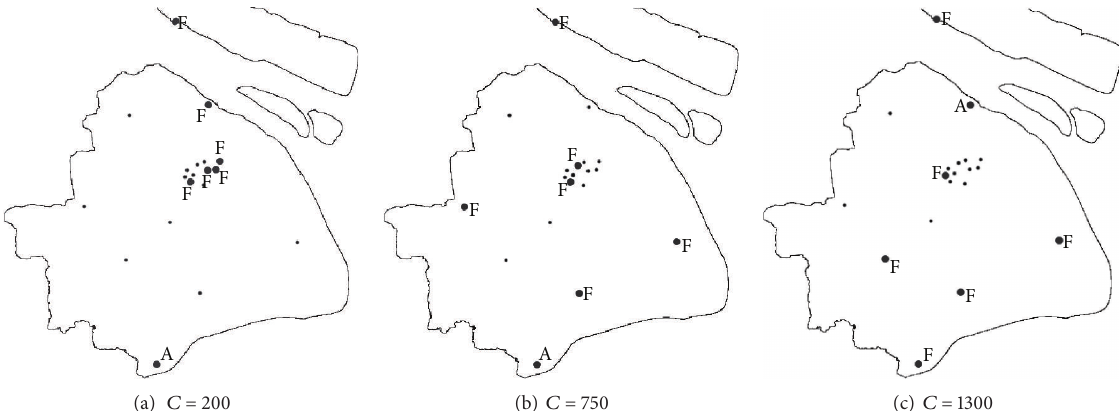
Figure 3: The facility location “F” and the district attacked “A” in equilibrium when 𝑚 = 6 under different scenarios.